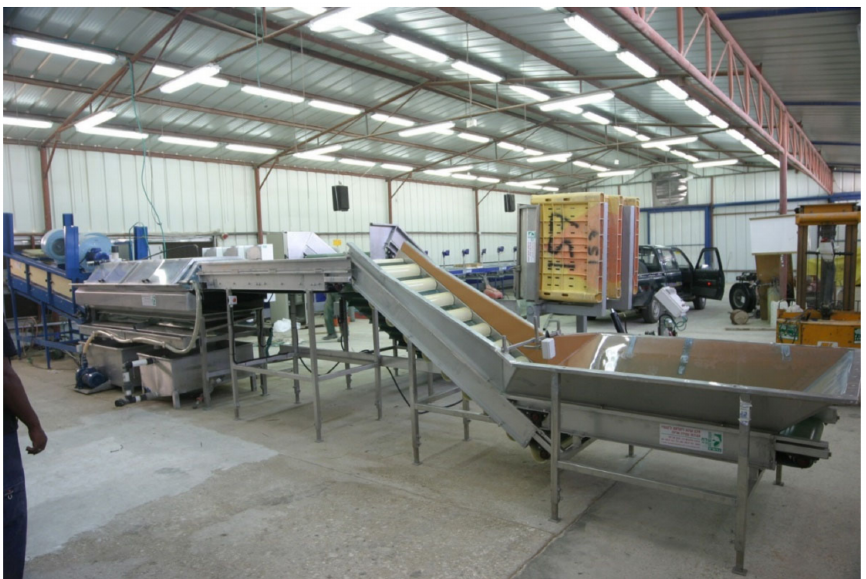
Figure 5. An HWRB machine for peppers and melons (photo by E.